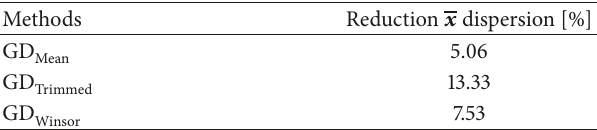
Table 41: Exponential with 1000